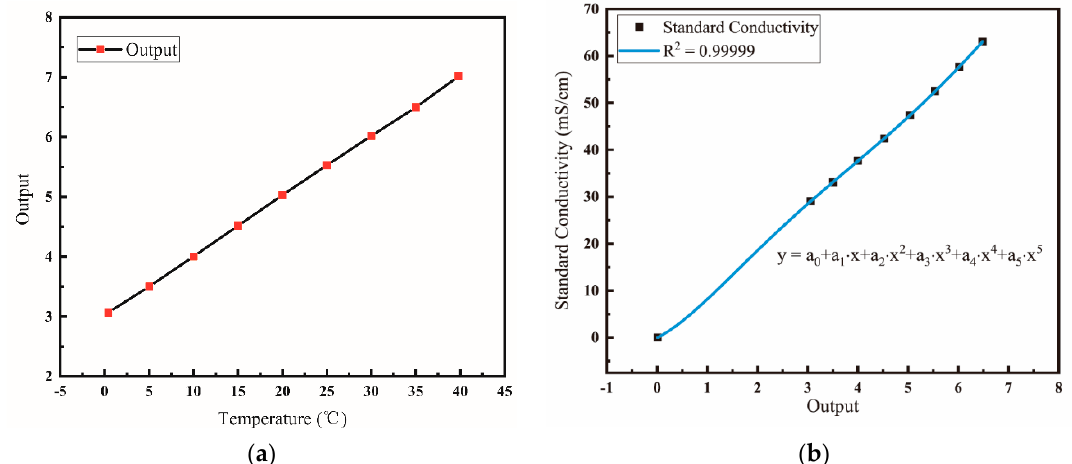
Figure 9. ( a ) Correspondence between temperature and circuit output. ( b ) Fitting curve calibrated by a third party, which is calibrated by changing the temperature of standard seawater.